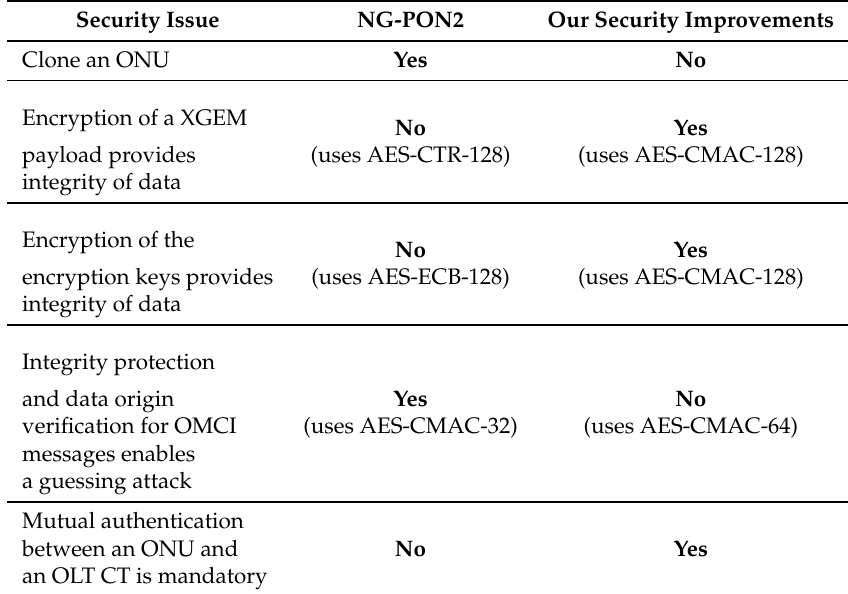
Table 5. Comparison between NG-PON2 and our security improvements in selected security